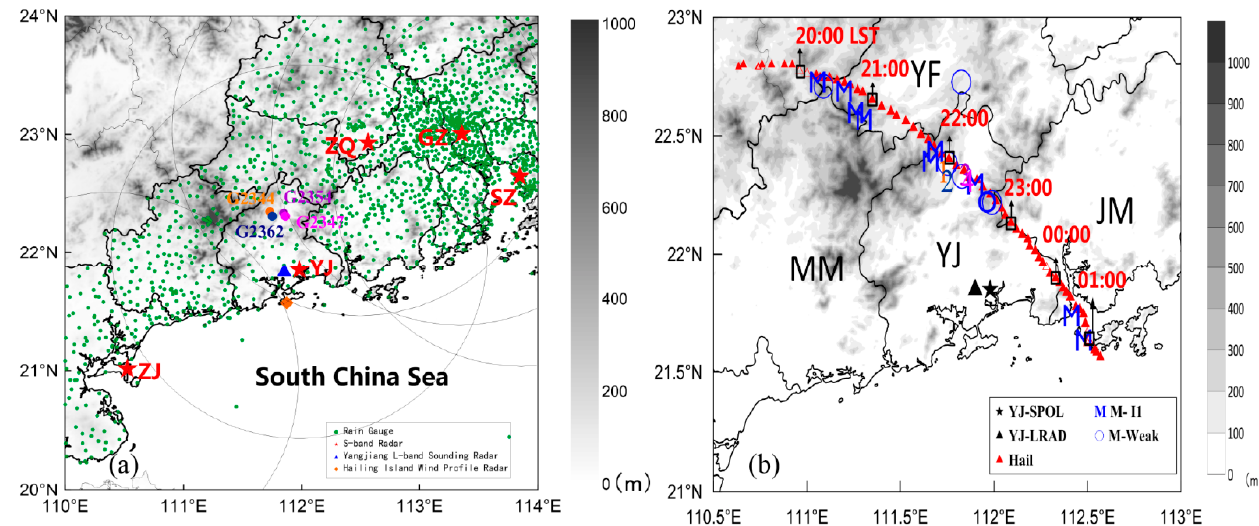
Figure 1. ( a ) Terrain height (shade, units: m) over the western part of South China coast. Provincial and municipal borders are marked with black lines. ( b ) The path of the hailstorm was tracked by radar. In ( a ), the five radars are represented by a red five-pointed star, with adjacent names in red. The radar scan radius is represented by black circles, with the green dots representing AWS. The orange, yellow, pink, and purple dots are used to mark the location of the automated stations near the area where hail was actually found. Wind profiler radar and sounding radar are marked with brown diamonds and blue triangles, respectively. In ( b ), the location of the hail is marked with a red triangle, the moderate cyclone is marked with the letter M and a blue circle. The Yangjiang radar station and the sounding stations are marked with a black five-pointed star and a black triangle. The four colored AWSs in ( a ) are marked with the numbers 1–4, in ( b ). Numbers indicate time.